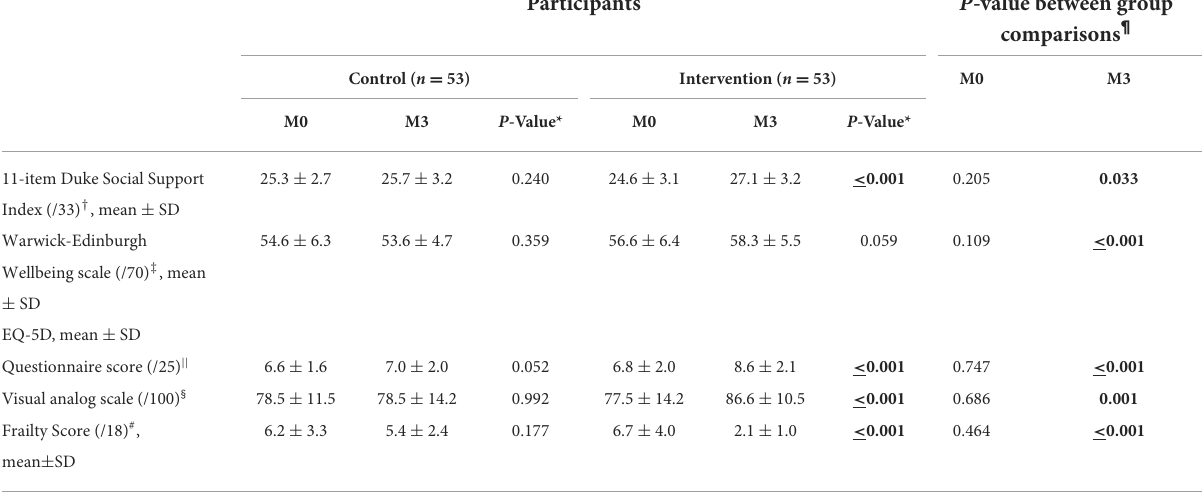
TABLE 2 Comparisons of mean values of scales assessing social isolation, wellbeing, quality of life and frailty between control and intervention groups ( n = 106).